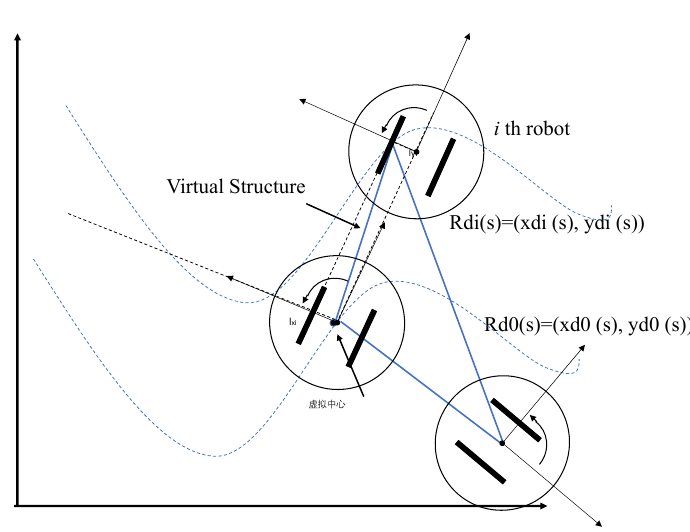
Figure 3. Virtual-structure-based formation